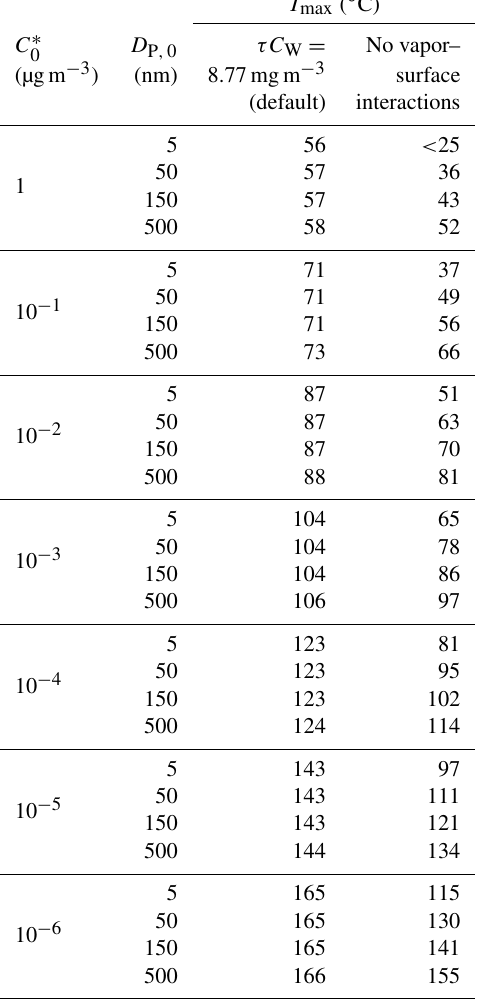
Table 1. Model-derived position of signal peak in temperature space ( T max ) for pure-compound particles and ranges of volatilities C ∗ 0 and particle sizes D P , 0 (cf. Fig. 5), and for vapor–surface interac- tions included vs. excluded. Other parameters are as for Figs. 5 and 6. T max ( ◦